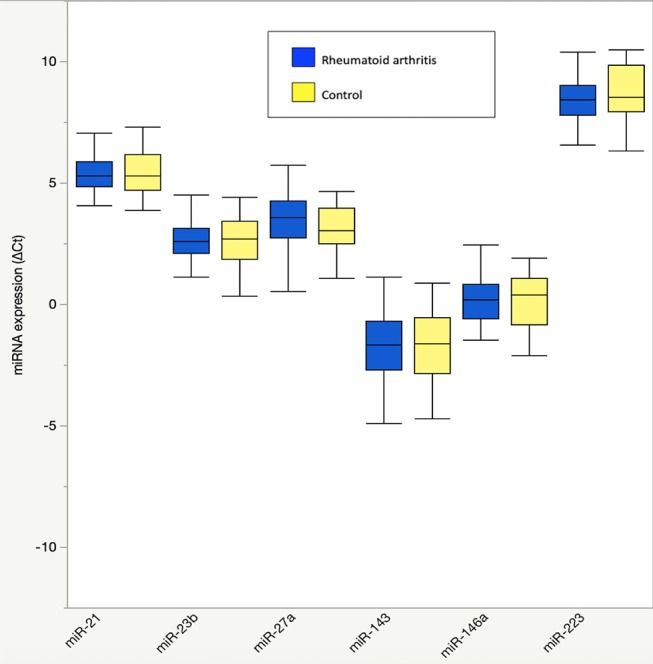
Plasma microRNA expression in rheumatoid arthritis compared to controls. Results are graphically displayed in box plots as medians, inter-quartile ranges (box), and upper and lower 25% of data values, excluding outliers (whiskers) for plasma expression of miR-21, miR-23b, miR-27a, miR-143, miR-146a, and miR-223 in rheumatoid arthritis (n = 48) and age-, gender-, and BMI-matched control subjects (n = 23). Plasma microRNA expression is reported as delta cycle threshold (ΔCt), where higher values are equal to higher expression. No significant group differences were seen in plasma microRNA expression (P > 0.05 for all).